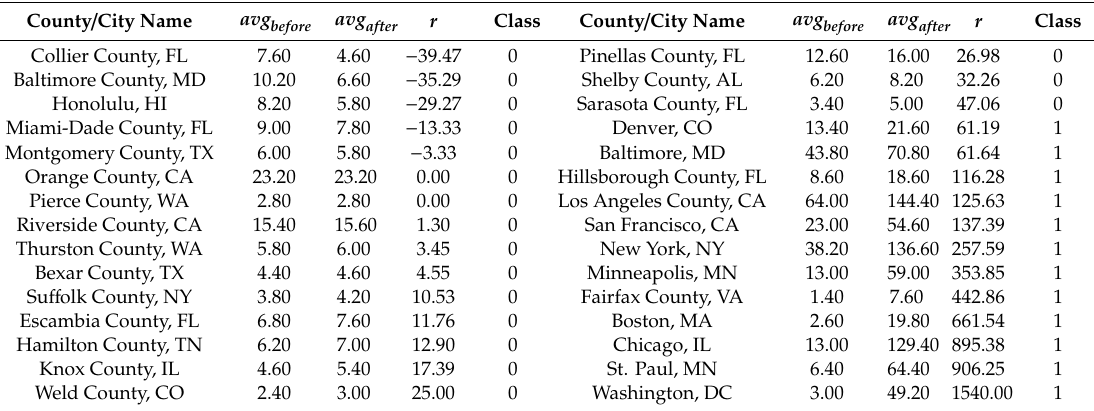
Table 3. Changing rates of